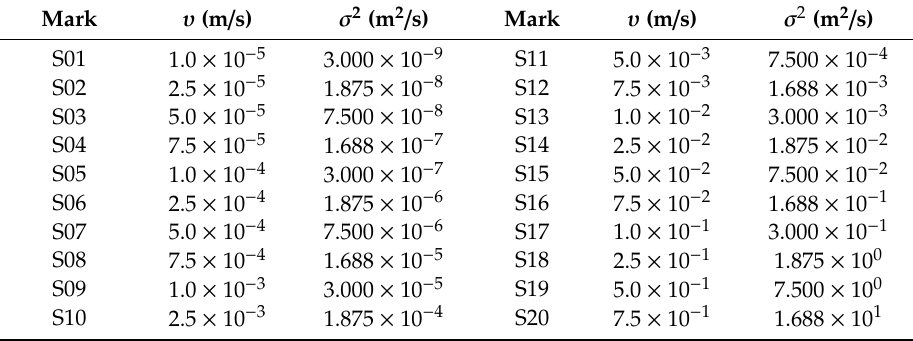
(cid:16) (cid:17) υ , σ 2